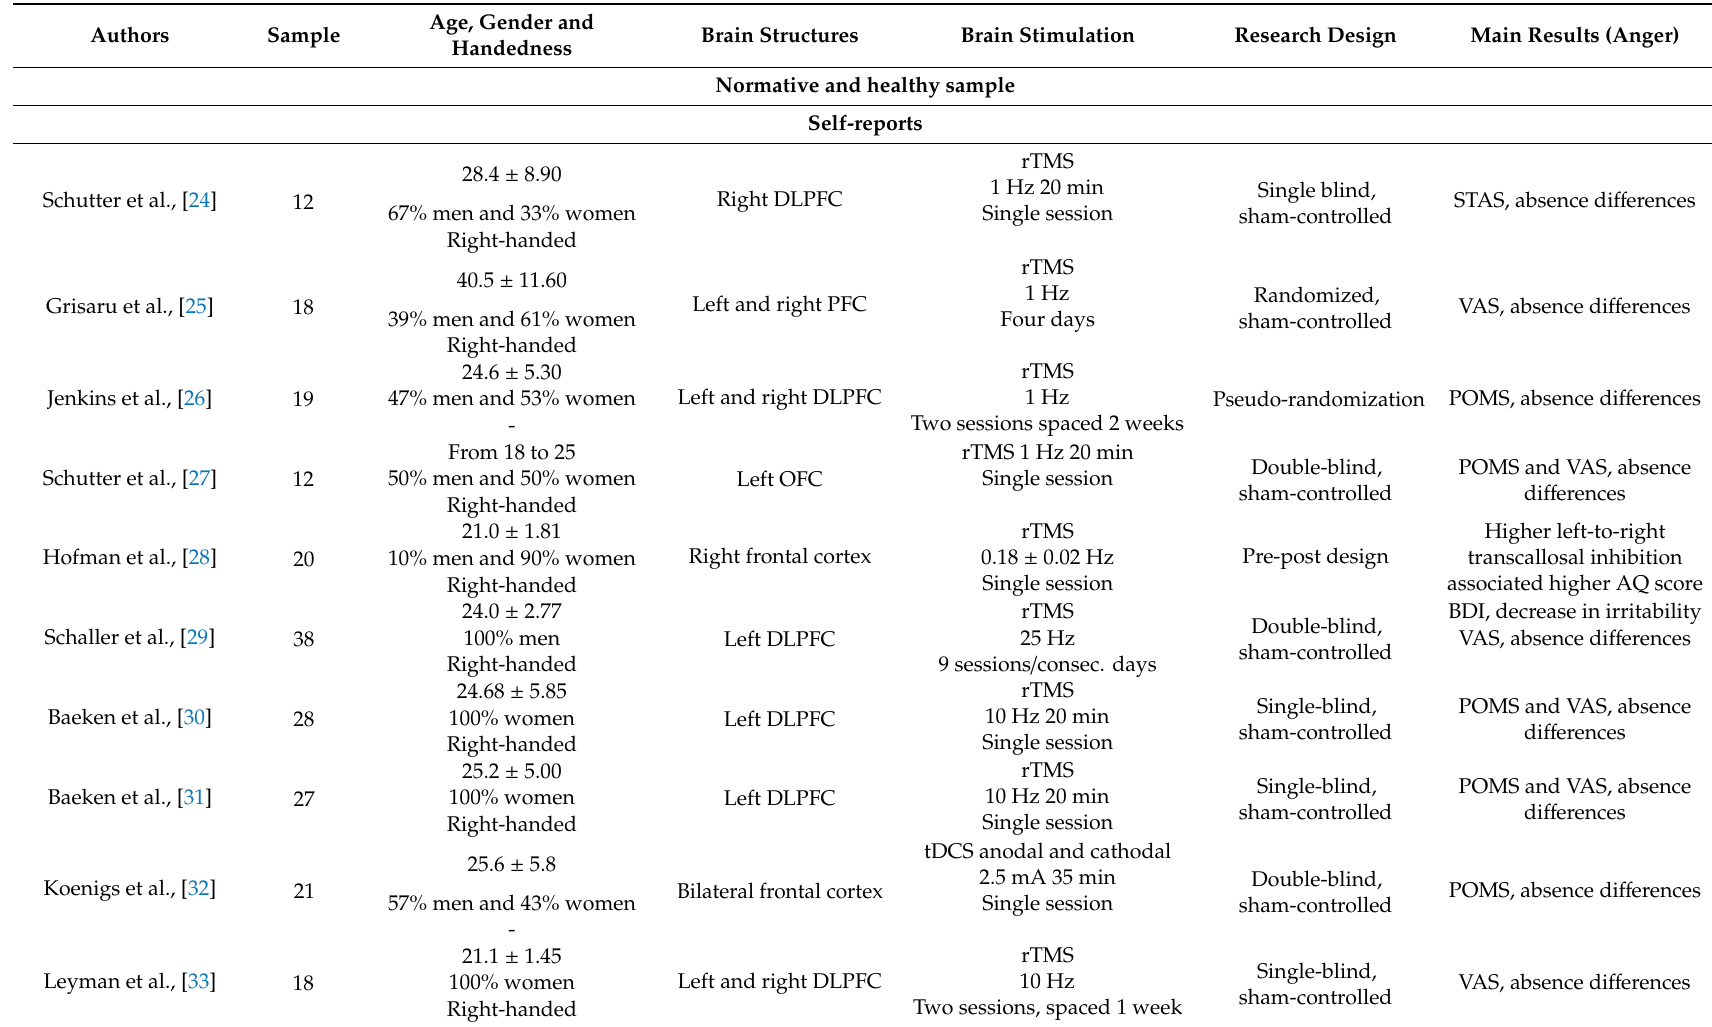
Table 1. Main sociodemographic characteristics and details about the participants in each study, the main results, and the assessment methods